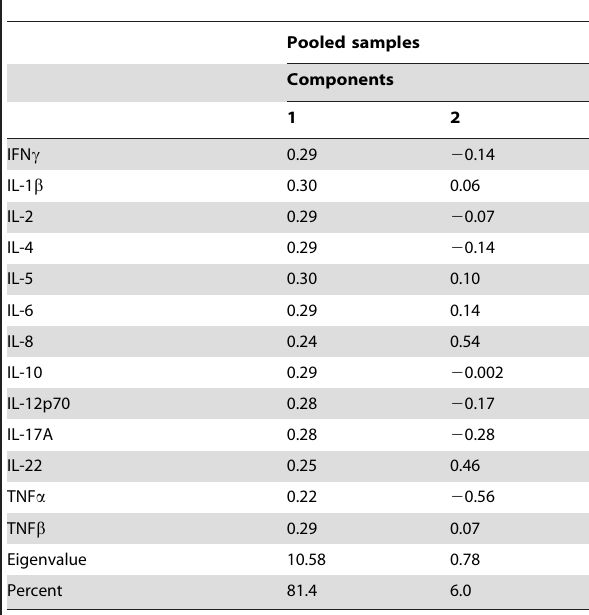
Table 3. Eigenvectors from principal component analysis of plasma cytokine levels of pooled Caucasians and First Nations